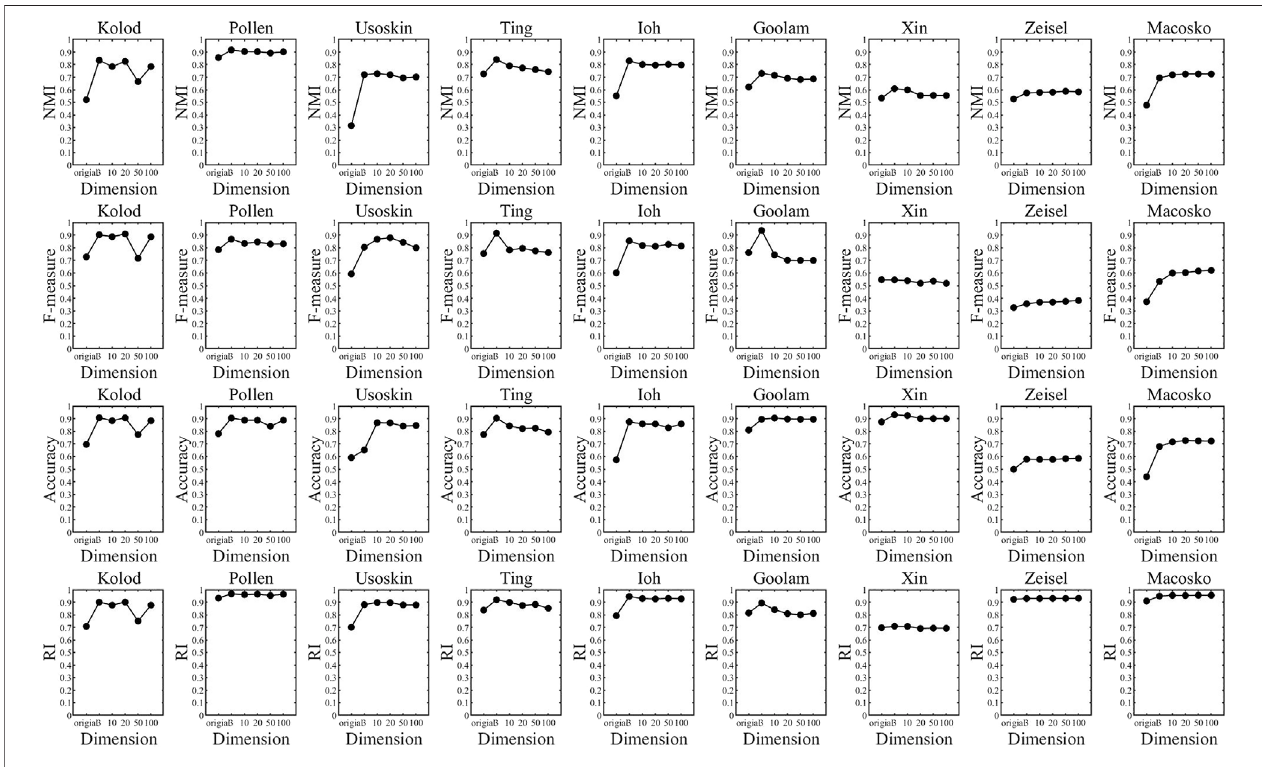
FIGURE 5 | Clustering index values of different dimension